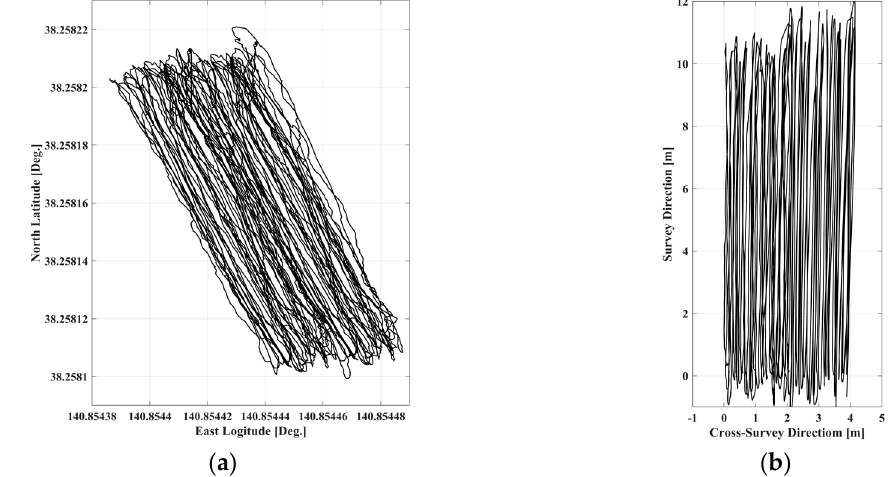
Figure 6. Moving trajectories of antennas recorded by the GlobalSat GPS receiver. ( a ) The record by the GlobalSat GPS receiver; ( b ) post-processing results.